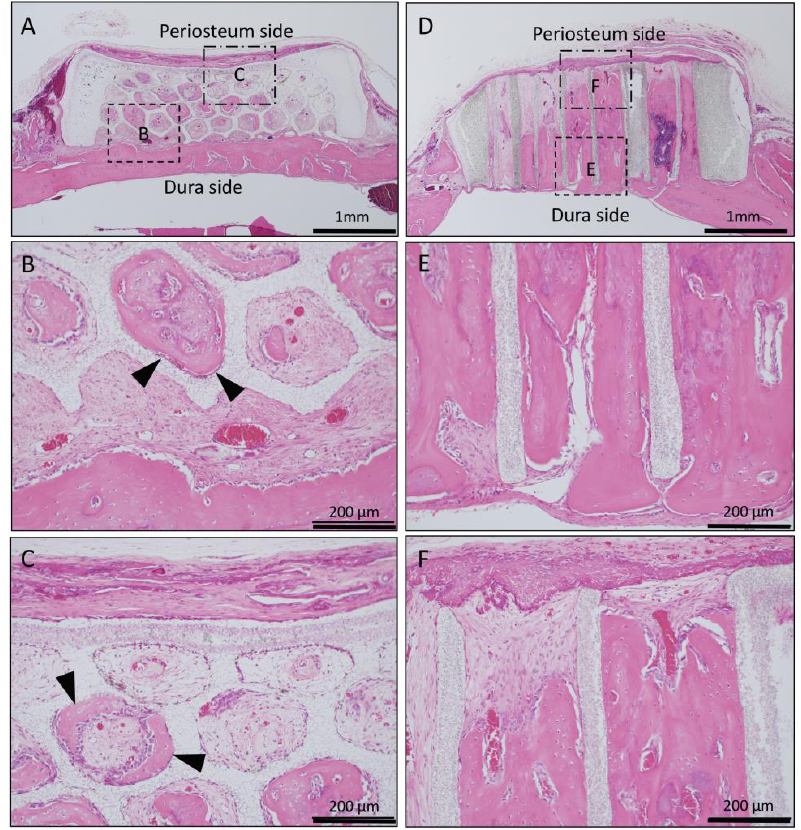
Figure 6. Histological images of β-TCP with Collagen gel + BMP-2 at 4 weeks after implantation. ( A ) Low-magnification image of horizontal β-TCP. No inflammatory granulation tissue was observed around β-TCP. ( B , C ) Higher-magnification image of corresponding outlined area in (A). Bone tissue formation was observed from the dura side to the periosteum side as if it was added to the inner wall of the hole (black arrowheads). ( D ) Low-magnification image of vertical β-TCP. No inflammatory granulation tissue was observed around β-TCP. ( E , F ) Higher-magnification image of corresponding outlined area in (D). All holes were filled with vigorous new bone, and the formation of bone marrow-like tissue and vascular cavity was observed in the area surrounded by the new bone tissue from the dura side to periosteum side.